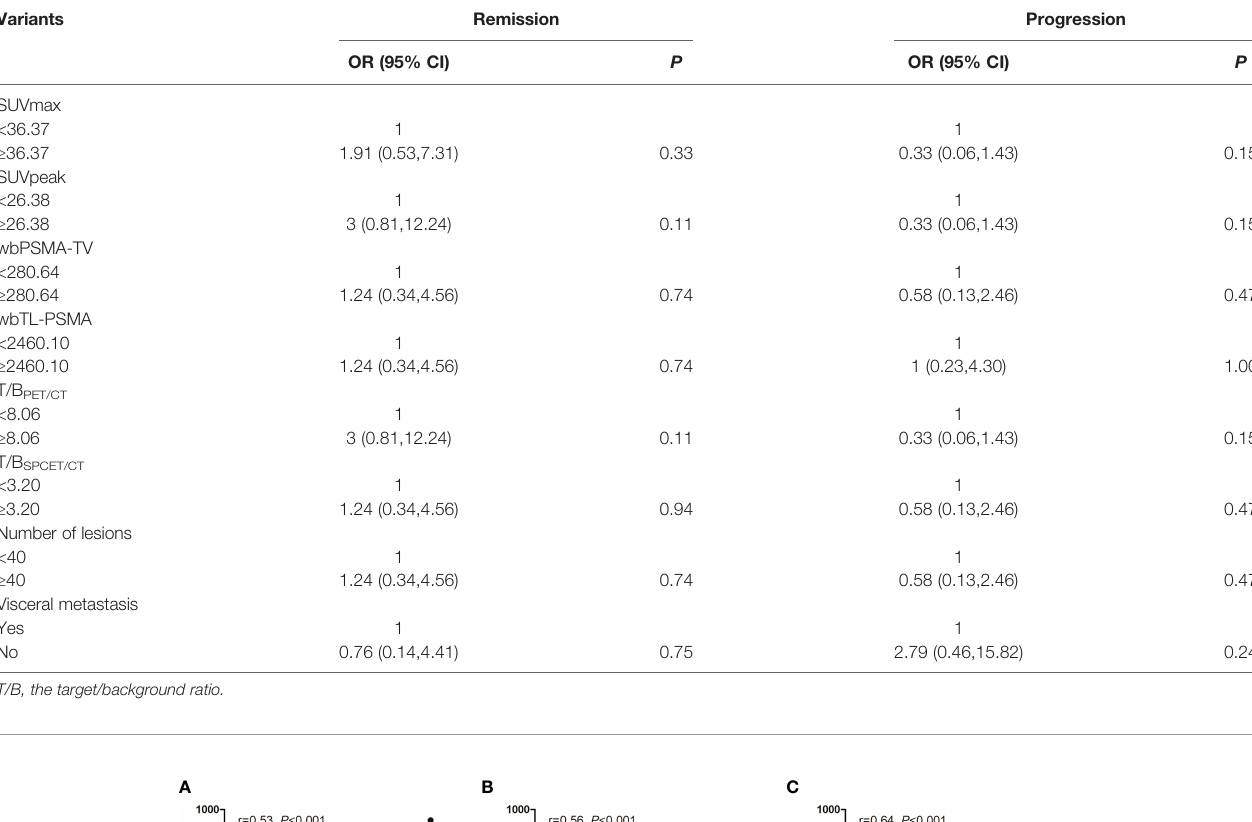
TABLE 5 | Univariate logistic regression analysis on basic imaging factors associated with therapeutic effect. Variants